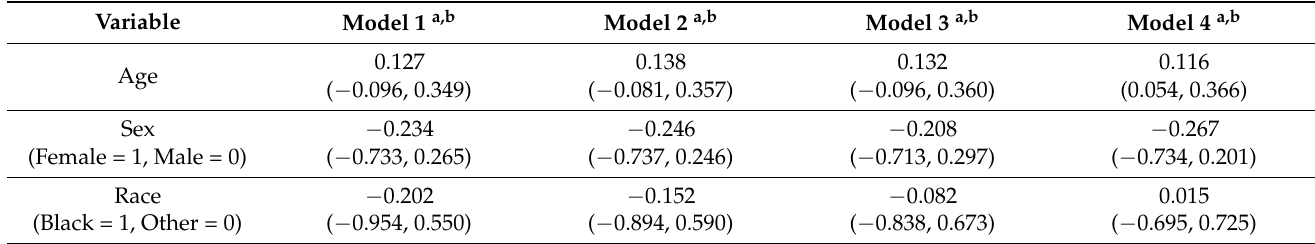
Table 2. Results of regression